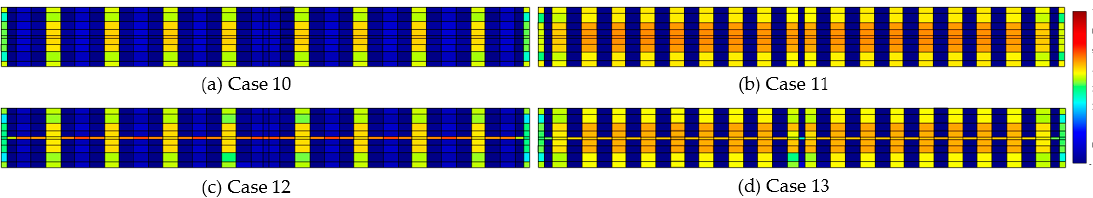
Figure 25. Comparison of conductivity distribution between different cases after 10 years, lg( k HF · d HF /md-m).